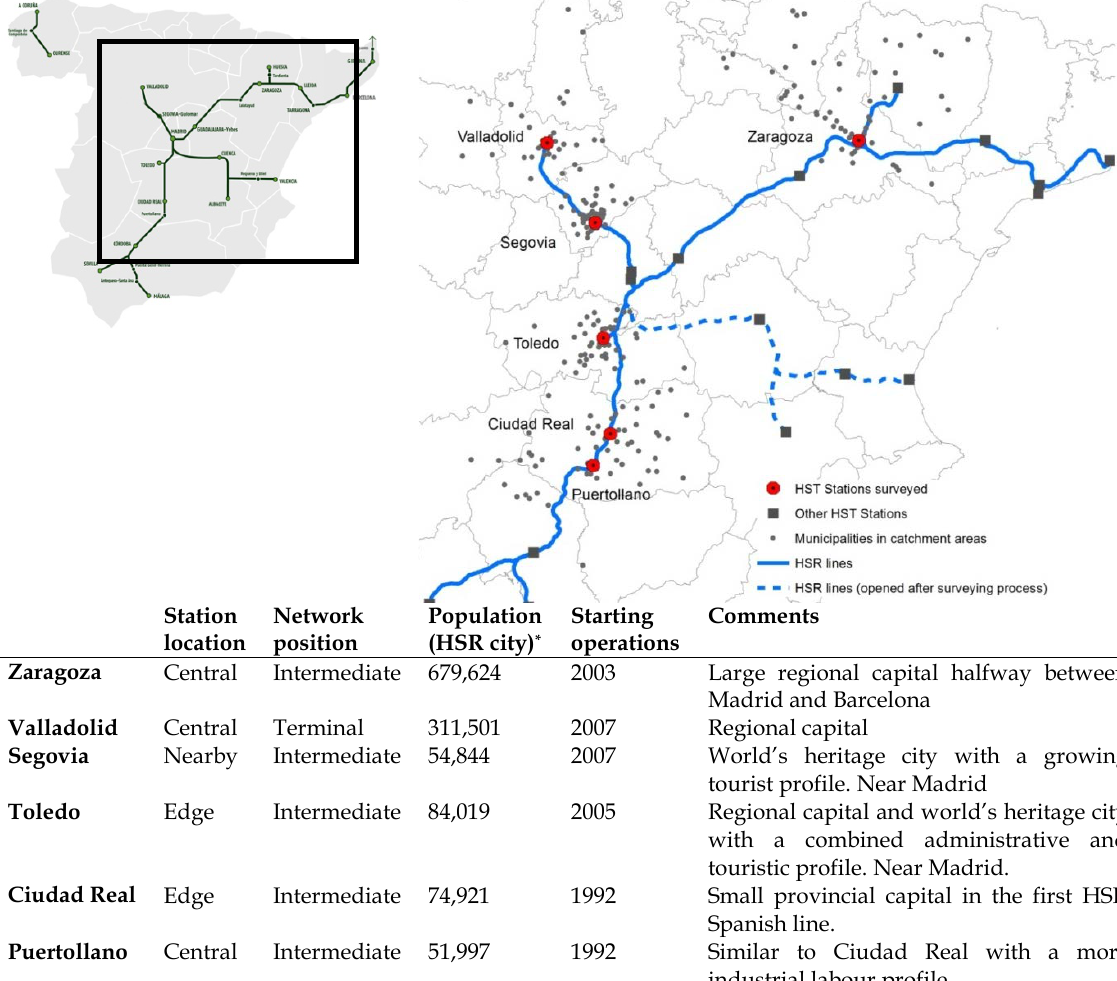
Figure 2. Case study. Source: * www.ine.es ; own